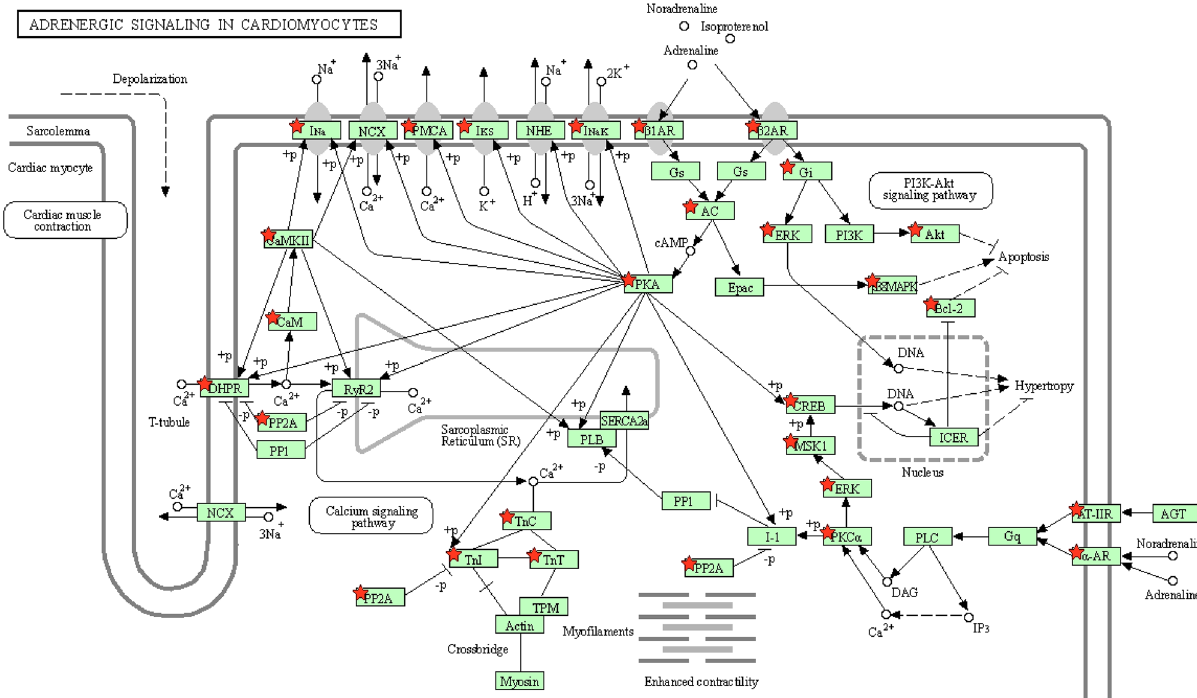
Figure 8. Distribution of the targets of Fuzi on the compressed adrenergic signaling in cardiomyocytes pathway. The nodes with red stars correspond to the targets of Fuzi, and the light blue nodes are targets in TNF signaling pathway. The compressed pathway was obtained from